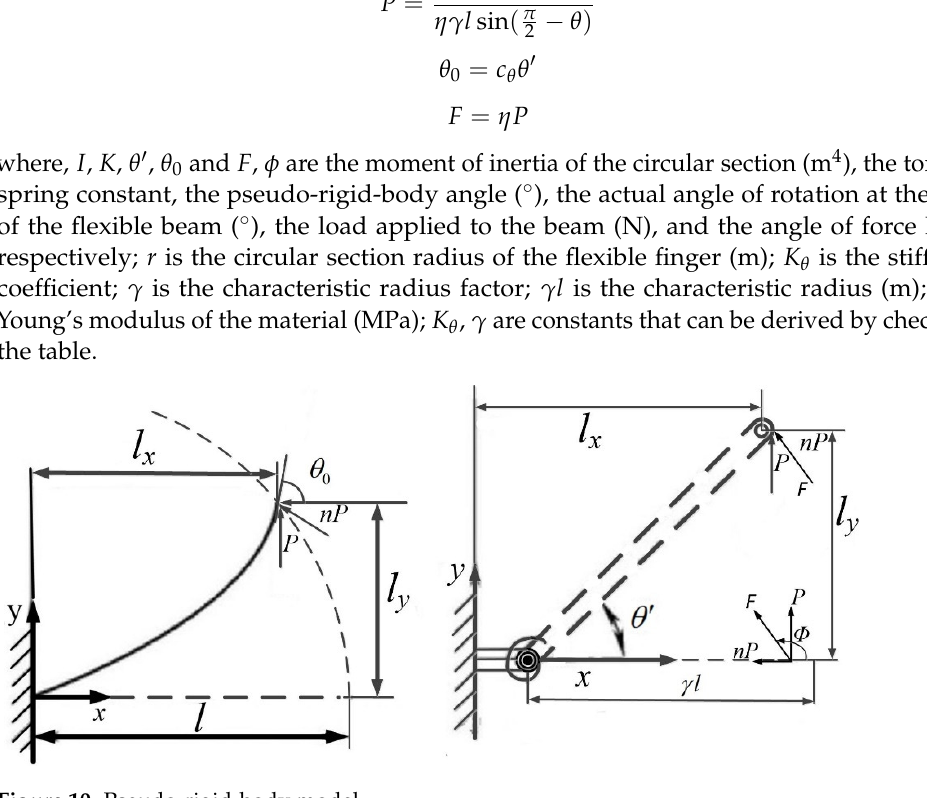
Figure 10. Pseudo-rigid-body model.